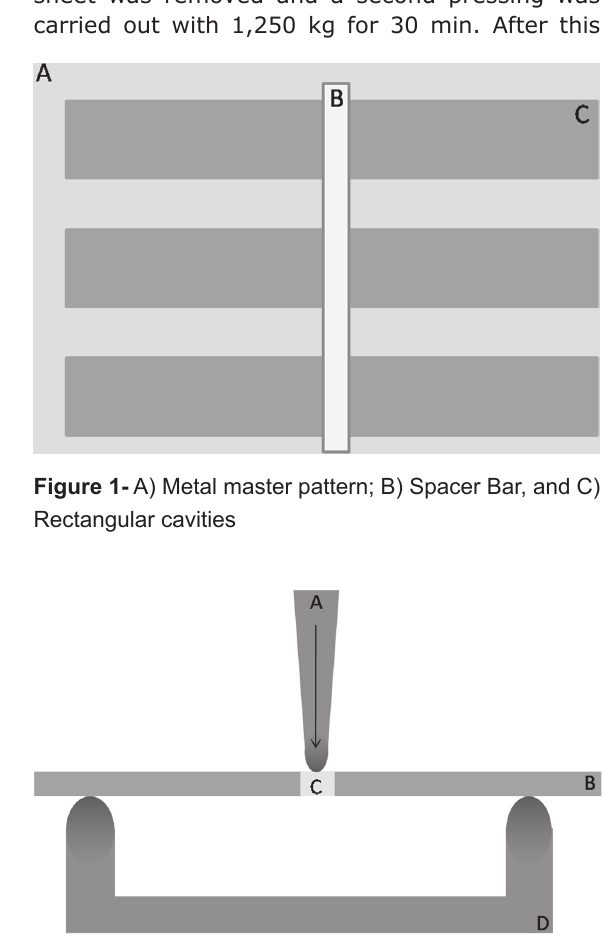
Figure 2- Scheme of test in MTS 810: A) round-end point, B) resin specimen, C) resin repair, and D) support